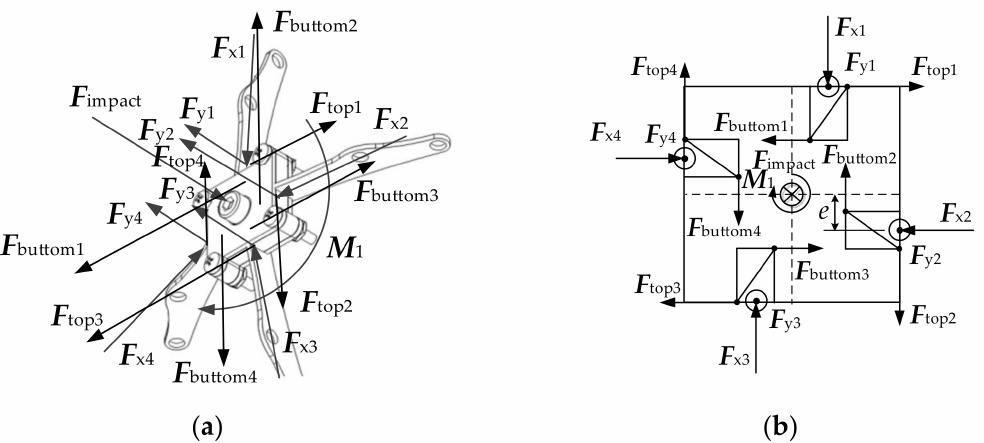
Figure 5. Force analysis of O-joint in intermediate transition state: ( a ) Force distribution diagram; ( b ) Force analysis